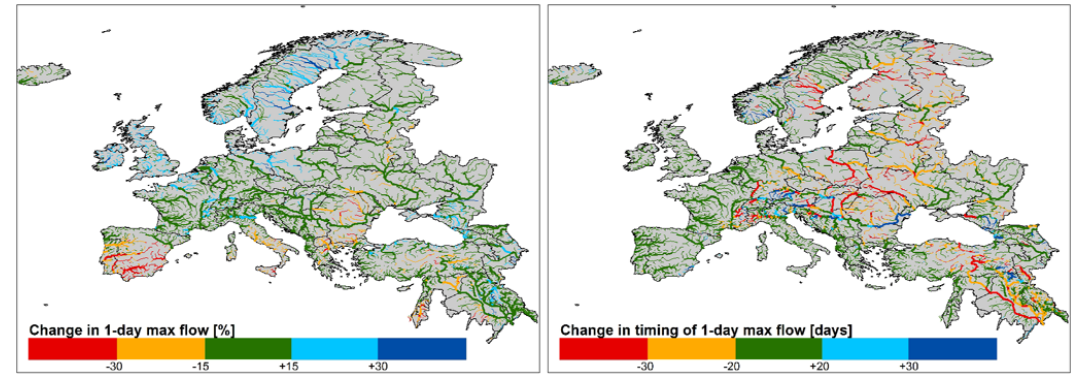
Fig. 5. Change of high flow magnitude and timing as a result of climate change represented by the ensemble mean for the 2050s.